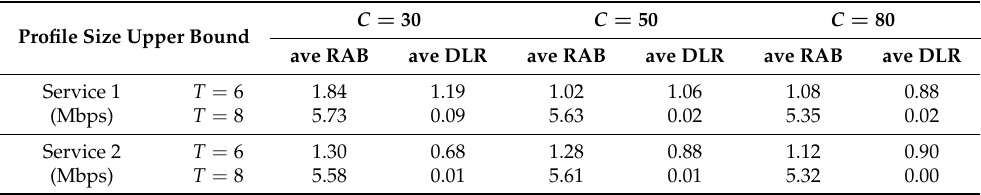
Table 9. The average DLR and RAB values of the proposed GRNN algorithm with different profile size upper bounds C and different QoS levels T